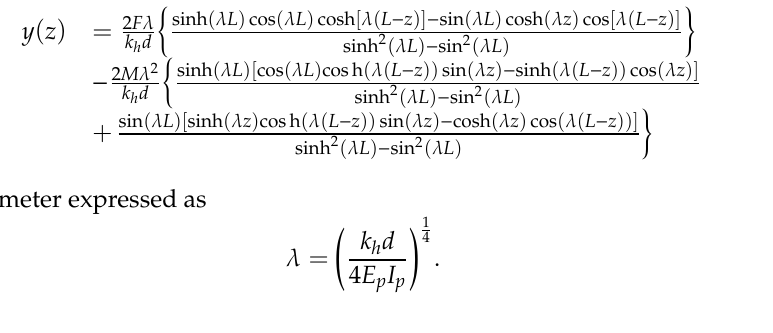
Table 1. Probabilistic information on the random parameters for static